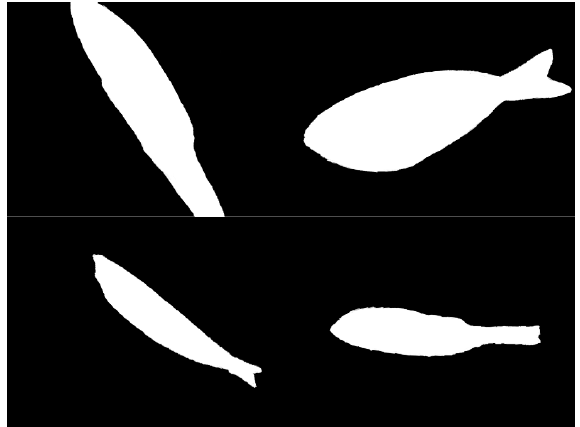
Figure 8. The ground truth of the dataset.